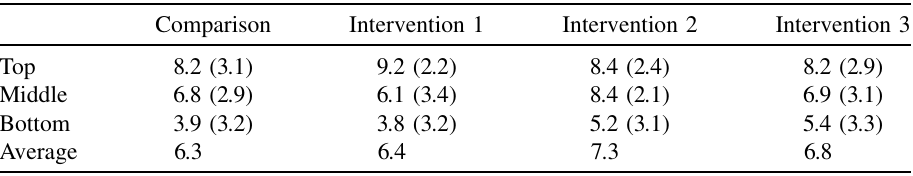
VII. Students’ average scores out of 10 on the quiz (transfer) problem in the calculus- based course. Note that the standard deviation in each case is shown in parentheses. The performance of the whole group taken together is represented by an unweighted mean of students’ average scores from the top, middle, and bottom